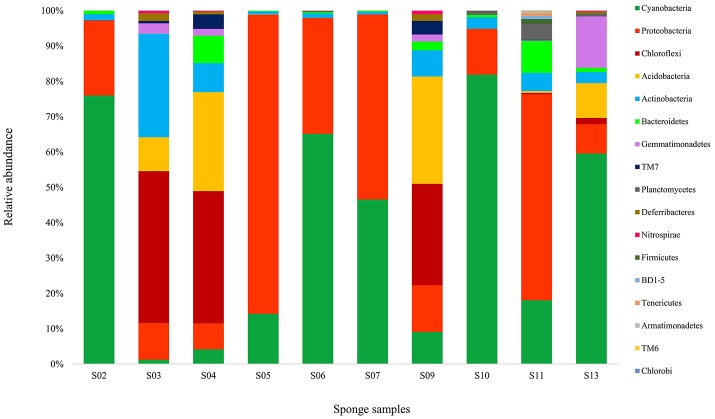
Taxonomic classification of bacterial sequences retrieved from different sponge samples collected from the Persian Gulf at the phylum level. Refer to Table 1 for sponge abbreviation.